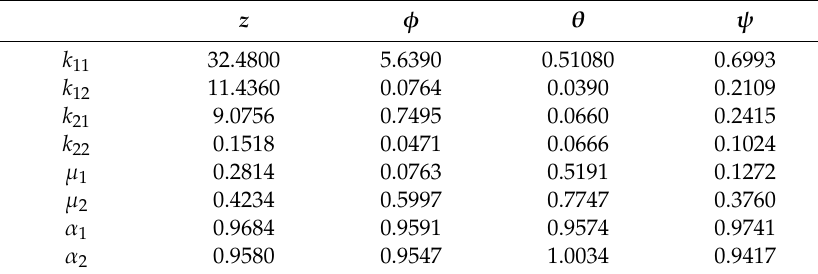
Table 5. NLPD parameters of the leader quadrotor.